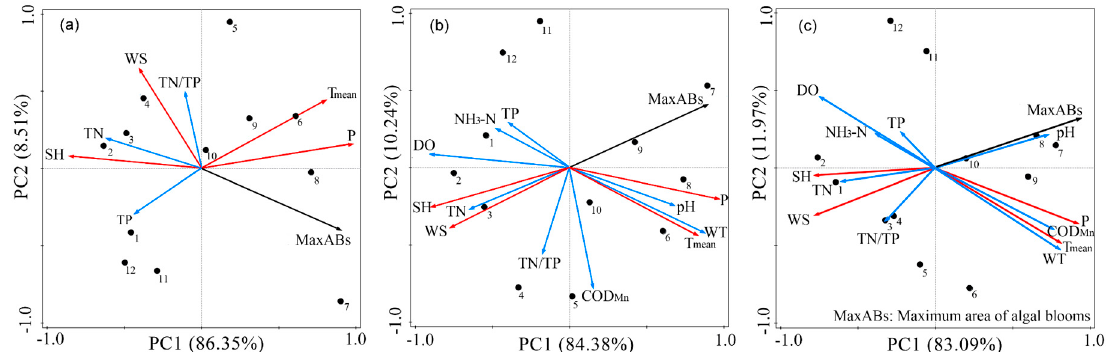
Figure 14. PCA ordination diagram of monthly algal blooms in Lake Dianchi. ( a ) 2000–2005; ( b ) 2006–2015; and ( c ) 2016–2018. Hollow circles, monthly algal bloom variables; red arrows, meteorological parameters; blue arrows, water quality parameters.